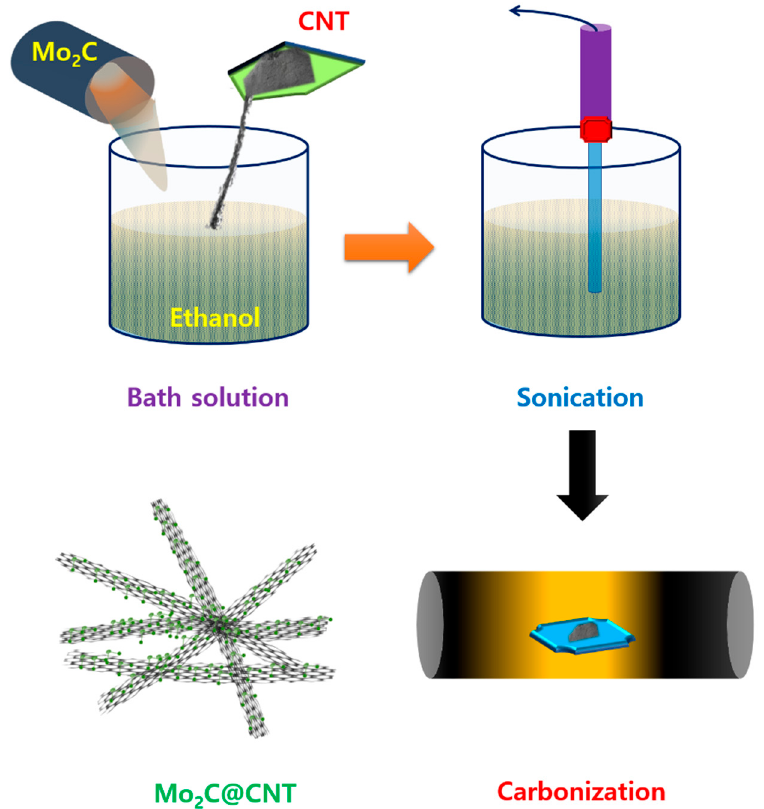
Figure 1. Graphic presentation for the synthesis of Mo 2 C@CNTs hybrid.